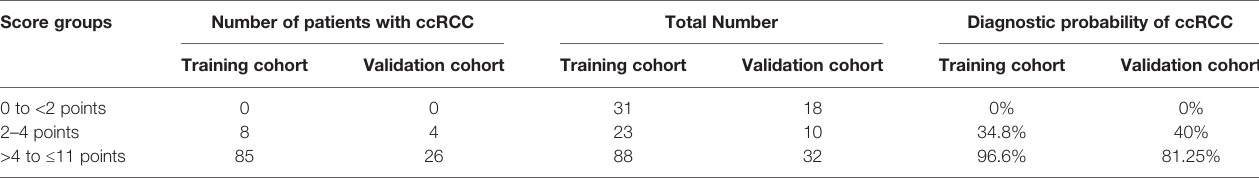
TABLE 3 | Patients with ccRCC among three groups in Training cohort and validation